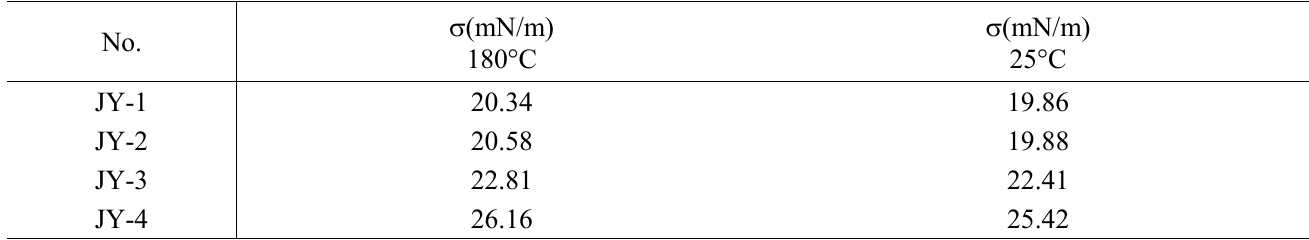
Table 4—Interfacial tension of composite surfactants.